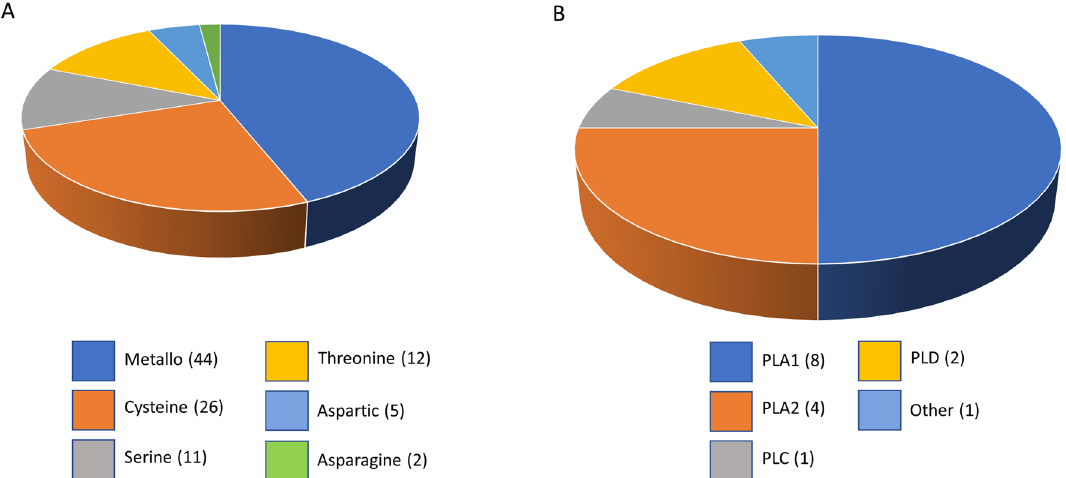
Figure 4. Representation in the intersect transcriptome of ( A ) protease super-families predicted by MEROPS and ( B ) manual annotated and categorised phospholipases (PL). The different colours represent different protease and lipase families.